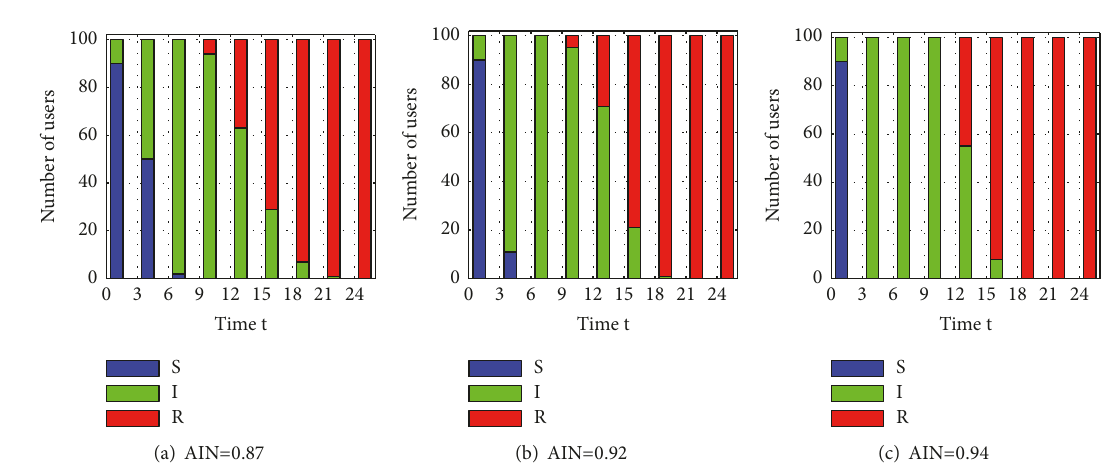
Figure 5: A comparison between awareness and no awareness.